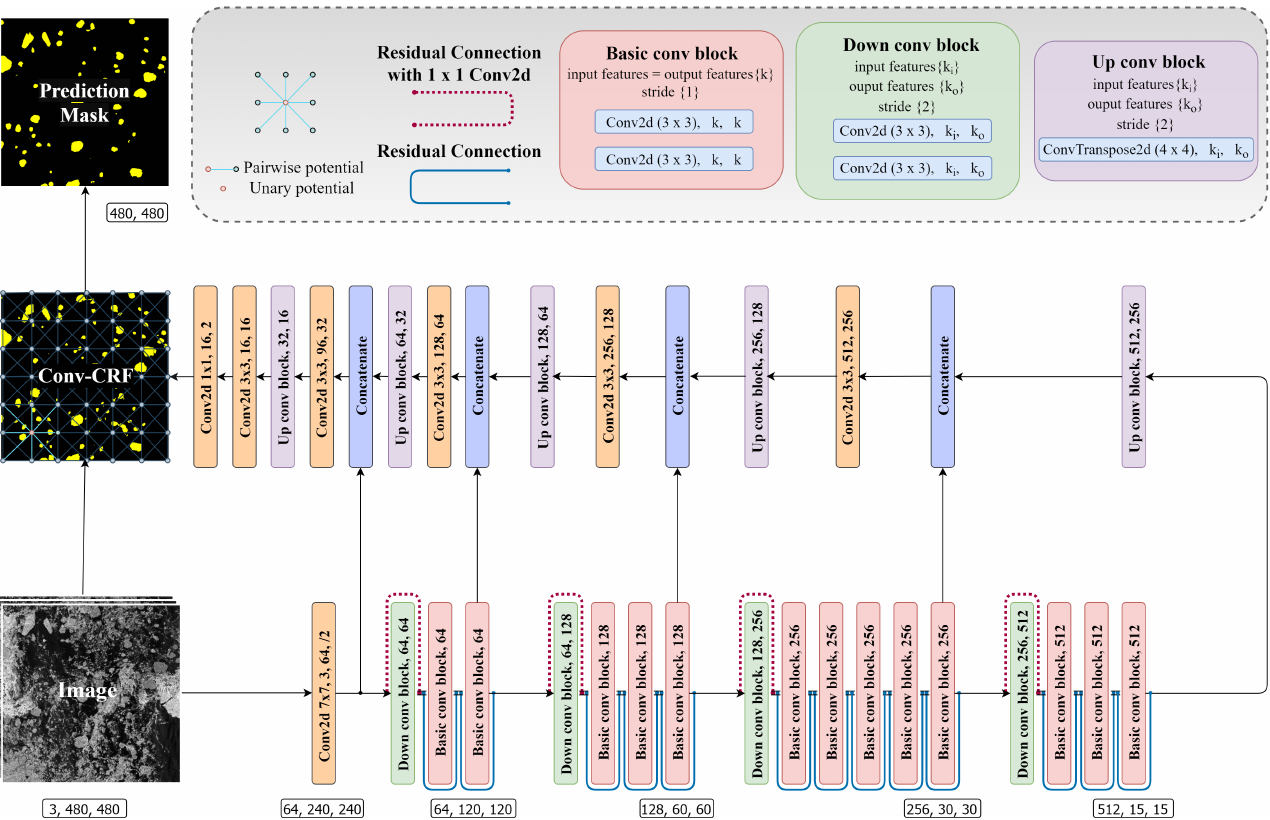
Figure 3. Figure of the proposed network architecture. The lower branch of the architecture consists of the downsam- pling/encoding path. The upper branch of the architecture consists of the upsampling/decoding path. Skip connections (interconnections between the two parts) help with integrating the location information in the downsampling paths to the contextual information in the upsampling path. The output of the final layer (loosely labeled mask) in the upsampling path is fed to the Conv-CRF as unary. Conv-CRF processes the loosely labeled mask along with input image to generate the Prediction